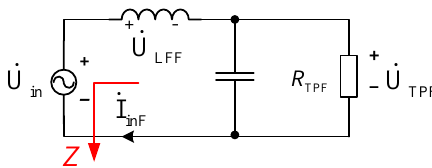
Figure 6. The line frequency phasor circuit.